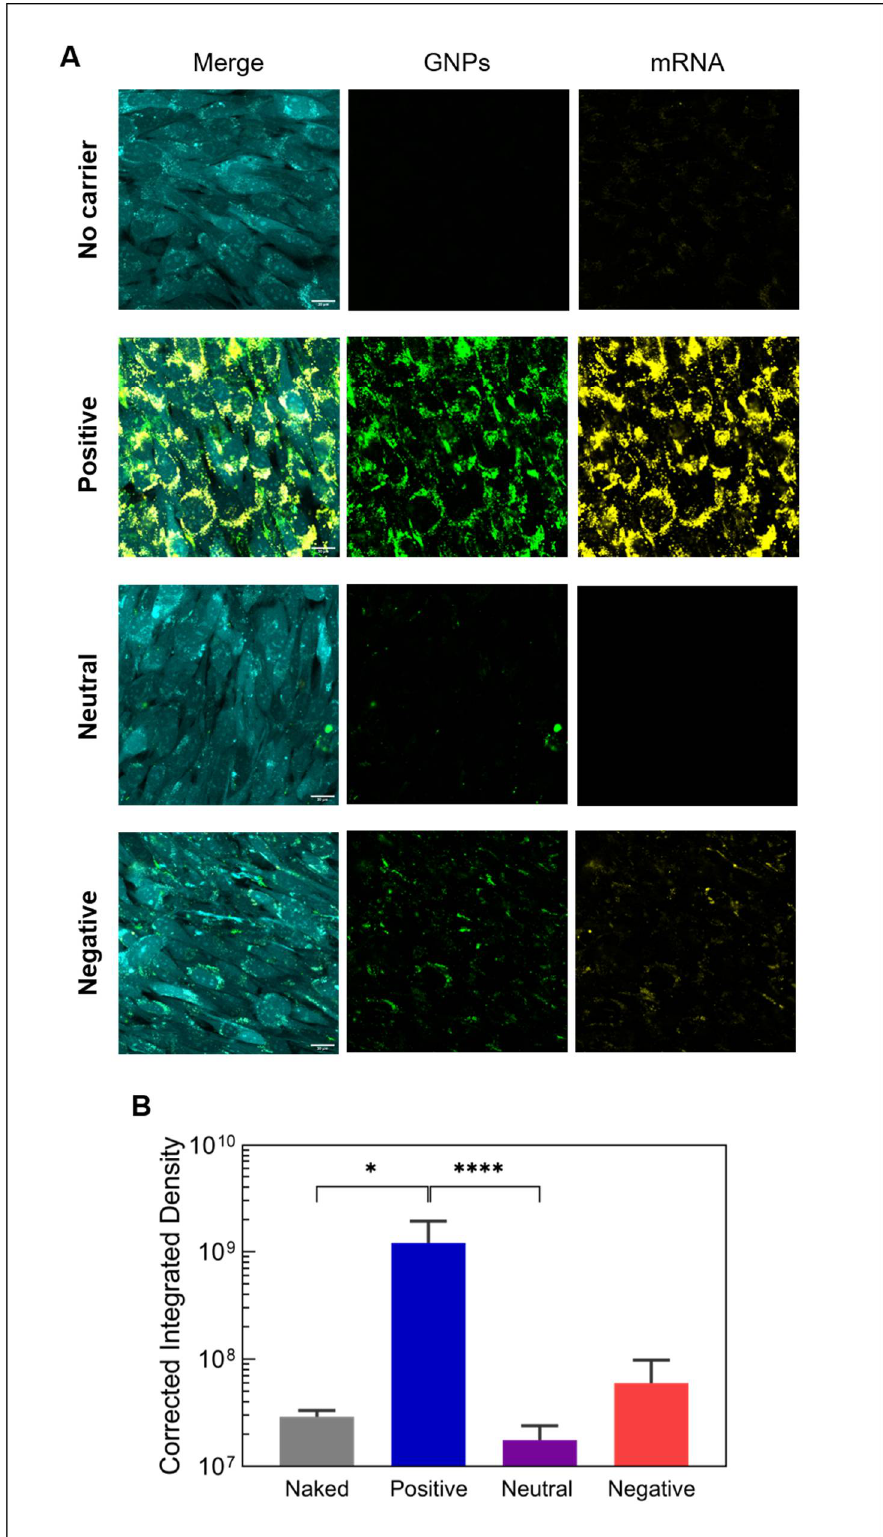
Figure 5. Internalization of mRNA-loaded gelatin nanoparticles. ( A ) Confocal live cell images show- ing the uptake of fluorescently labeled mRNA (yellow) by mouse pre-osteoblastic cells (cyan) after 24 h using differently charged gelatin nanoparticles (green) and ( B ) the quantification of internalized mRNA ( n = 6). Naked mRNA refers to mRNA delivered without any vector or particle (no carrier). All images were acquired using the same acquisition settings. Scale bar represents 20 μm. Statistical significance is shown as * p < 0.05 and **** p < 0.0001.